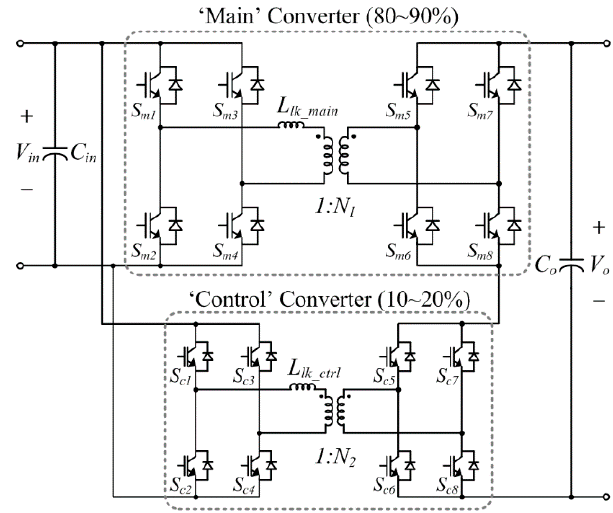
Figure 2. The proposed bidirectional double uneven power (BiDUP) dc-dc converter.